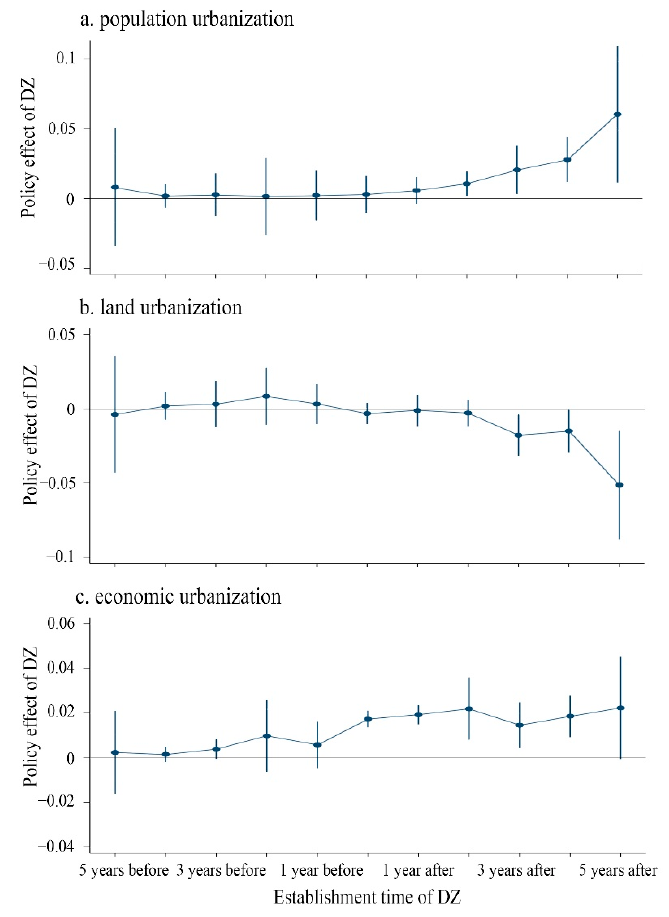
Figure 2. Parallel trend test plots.